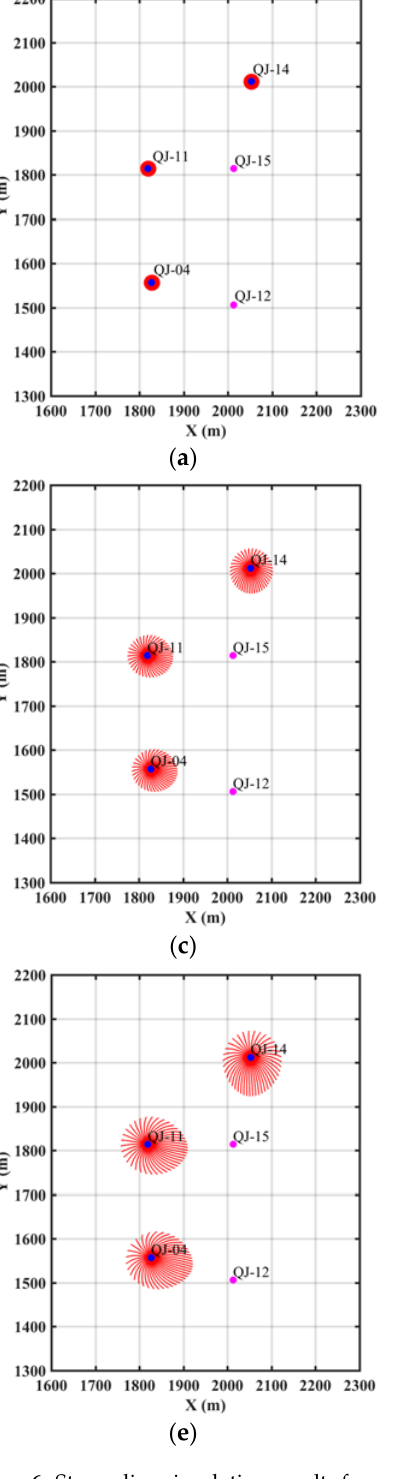
Figure 6. Streamline simulation results for porosity φ = 0.1. ( a ) t = 0.1 day; ( b ) t = 0.4 day; ( c ) t = 0.8 day; ( d ) t = 1.2 day; ( e ) t = 1.6 day; ( f ) t = 2 day; the red lines are water flow trajectories.